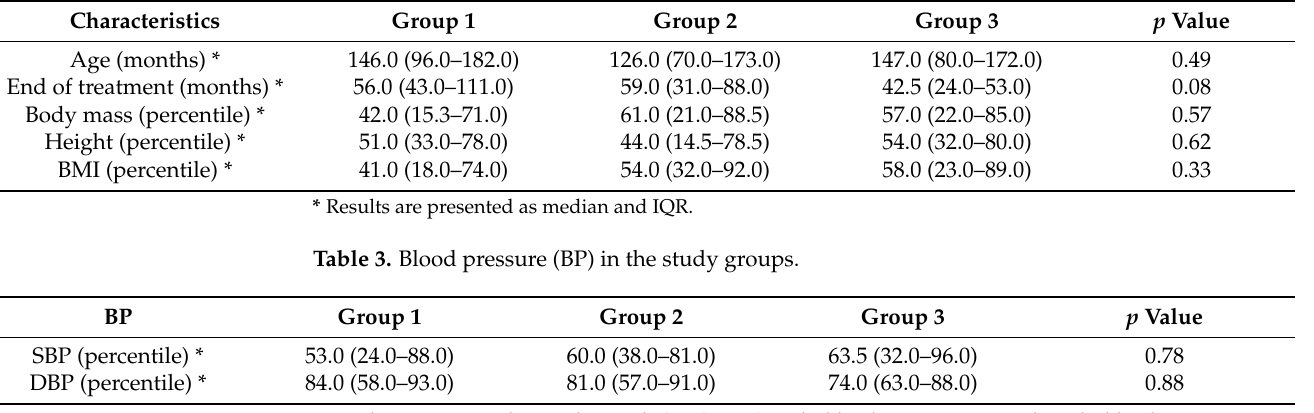
Table 2. Age, time from the end of treatment, body weight, height, and body mass index (BMI) in the study